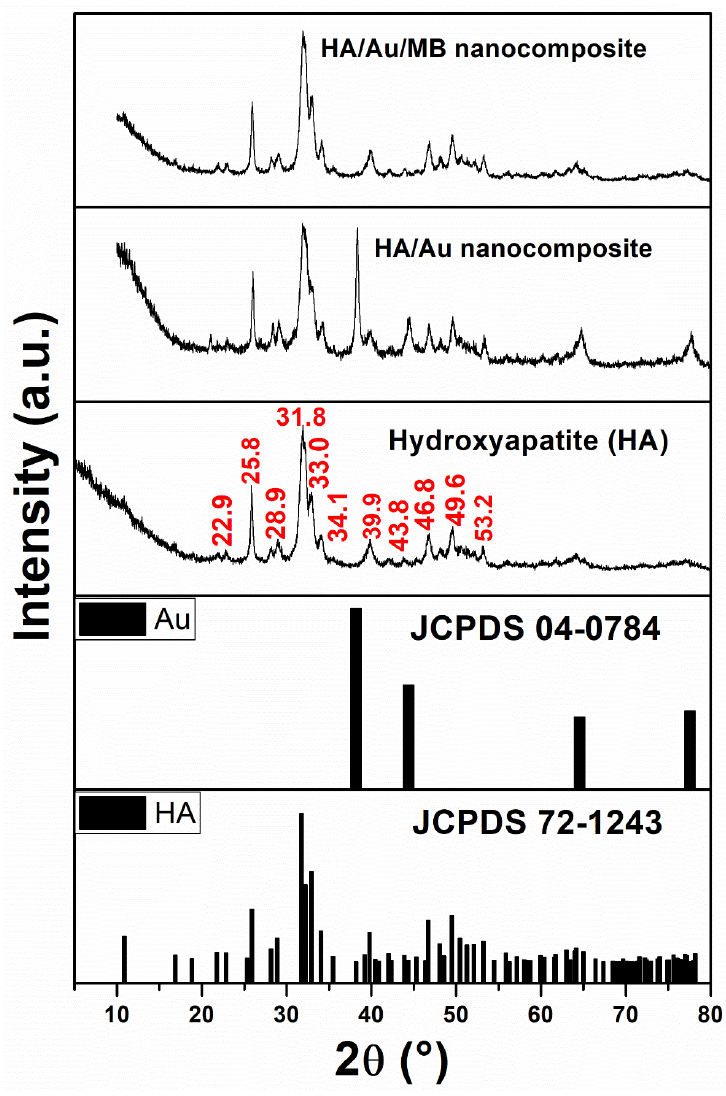
Figure 2. XRD patterns of the pure HA, HA/Au nanocomposite and HA/Au/MB